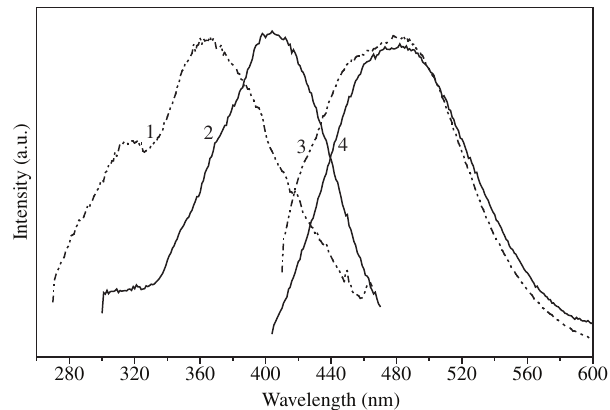
Figure 9. Acid-basic equilibrium of 9-AA in protic solvents.